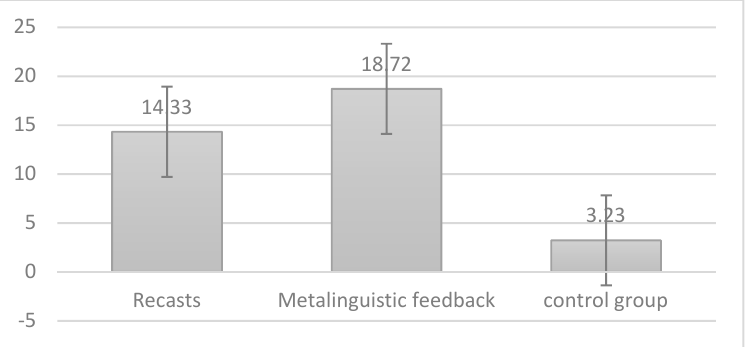
Figure 2. Percentage variance of the gains on students’ scores.